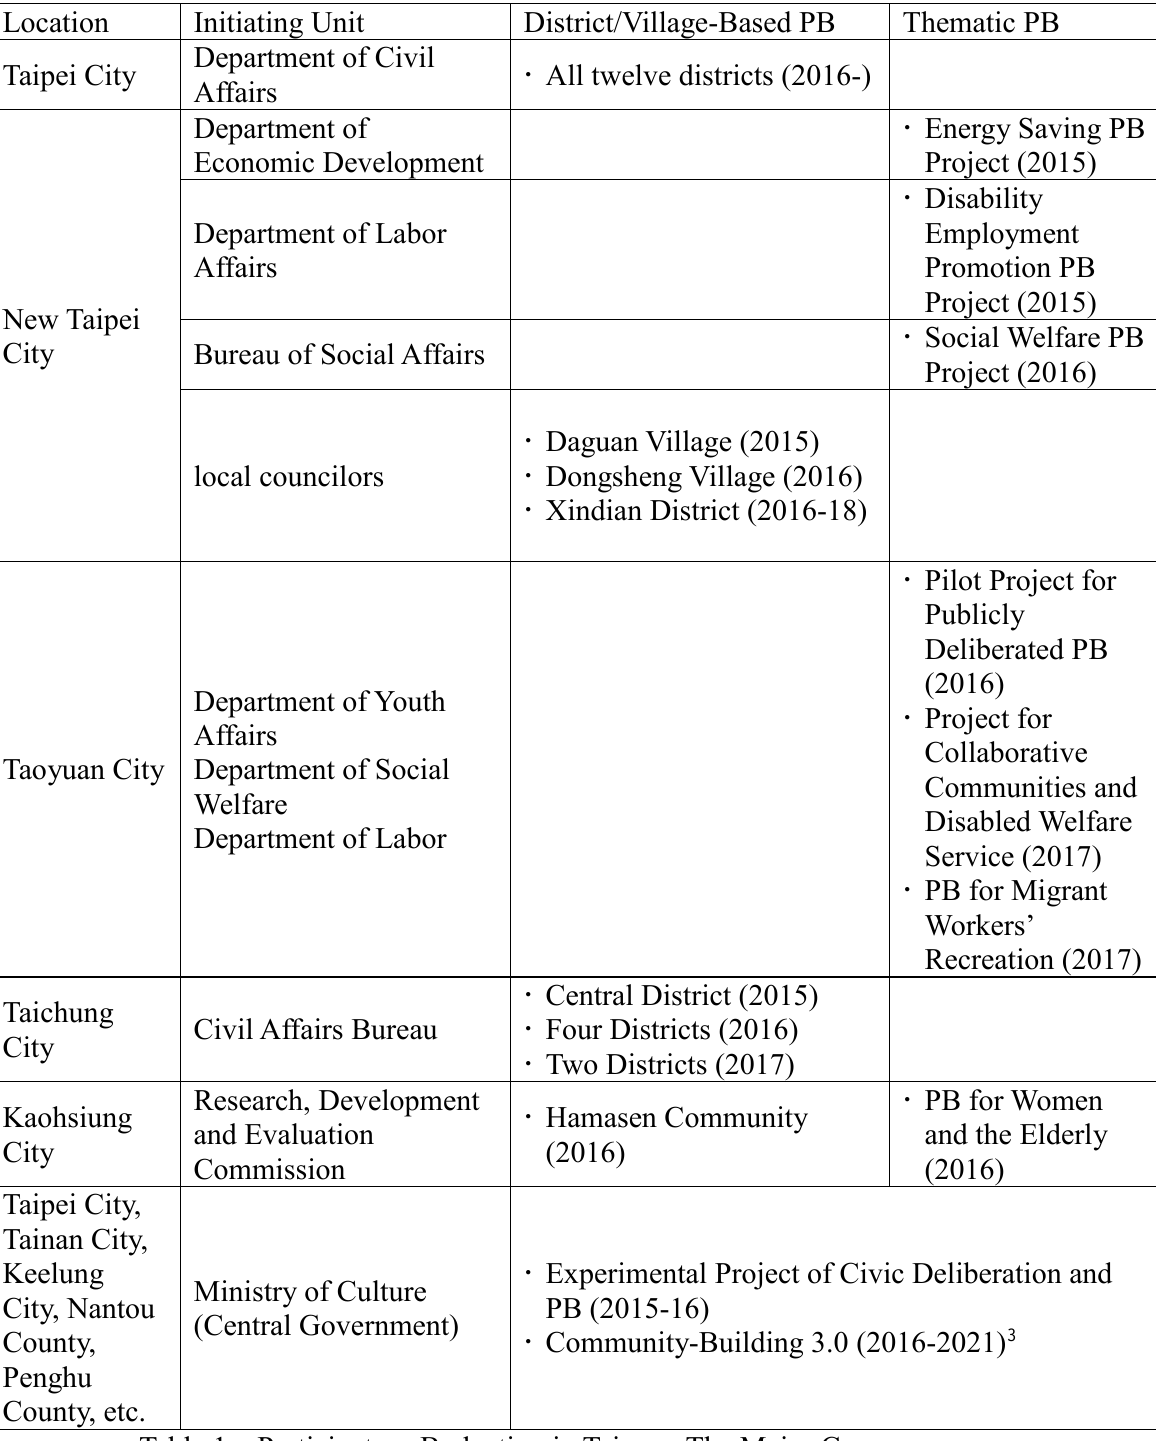
Participatory Budgeting in Taiwan: The Major